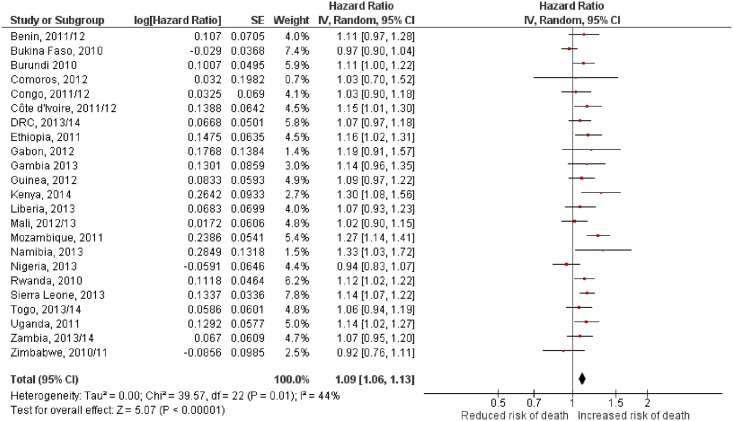
Relationship between exposure to secondhand tobacco smoke and the risk of under-five mortality in Sub-Saharan Africa from a meta-analysis of 23 countries.The red dot indicates the hazard ratio (HR) for a country. Horizontal lines cover the 95% confidence intervals (CI). The diamond is centered at the pooled HR and is as wide as the 95% CI. HR > 1 implies a higher risk of mortality for the children under five exposed to secondhand tobacco smoke.